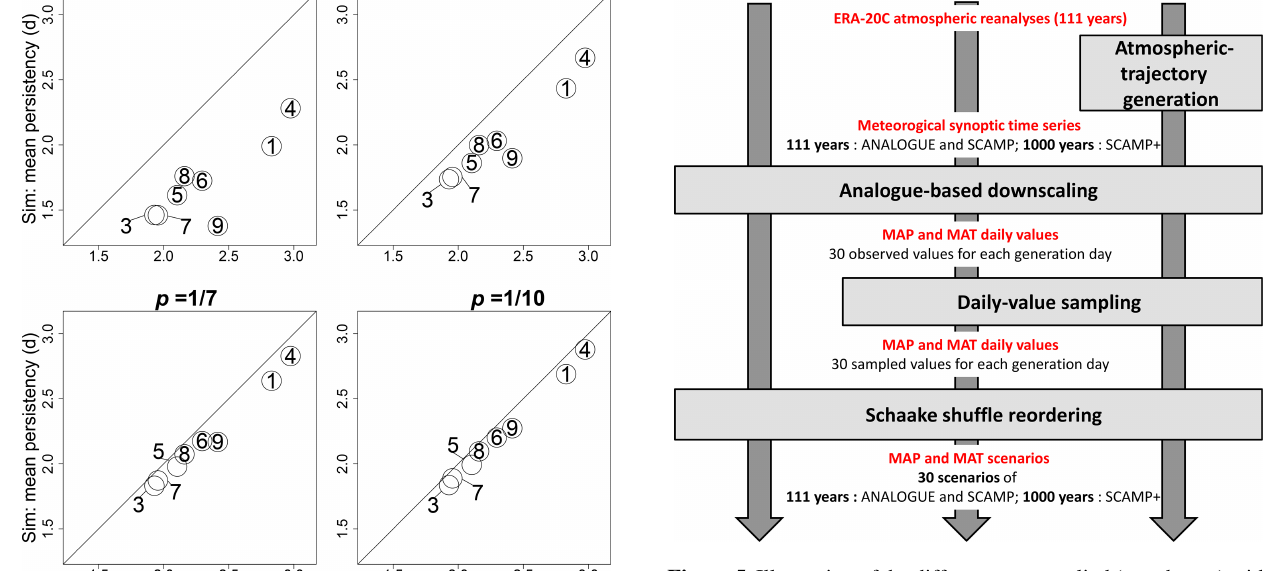
Figure 5. Illustration of the different steps applied (grey boxes) with models ANALOGUE, SCAMP and SCAMP + . Outputs obtained after each step are indicated in